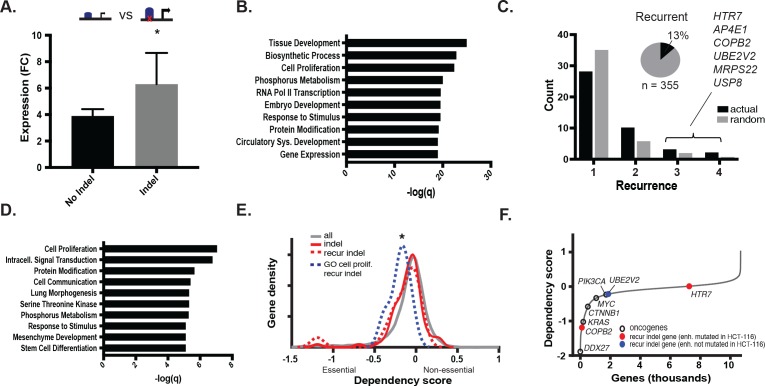
MSI enhancer indels impact target gene expression.(A) Mean fold-change of expression (CRC/crypts) of genes associated with gained enhancers containing indels (grey; n = 352 sample-gene pairs) versus the same genes in cell lines with gained enhancers but lacking indels (black; n = 2384 sample-gene pairs). *p<0.01, 2-sample t-test (Figure 3—source data 1). (B) Enriched GO terms associated with enhancer indel genes. (C) (black) Distribution of number of TCGA samples with recurrent indel and (grey) average recurrence distribution from random sampling of TCGA indels (p<0.05, χ2 test). Listed genes have indels recurrent in three or more TCGA samples. Pie chart shows fraction of enhancer indels that are recurrent in at least one primary CRC tumor (Figure 3—source data 2). (D) Enriched GO terms associated with recurrent enhancer indel genes. (E). Distribution of dependency scores in HCT-116 cells for all expressed genes (grey; n = 13,584), indel genes (red; n = 100), recurrent indel genes (dotted-red; n = 17), and recurrent indel genes with ‘Cell Proliferation’ annotation (dotted-blue; n = 5). *p<0.05 for ‘Cell Proliferation’ recurrent indel gene versus all expressed genes, Wilcox ranksum test. (F) Genes ranked by dependency scores, showing select oncogenes (black circles), and recurrent indel genes with (red circles) and without (blue circles) enhancer mutation in HCT-116 cells. Data for recurrent indel genes shown in ‘C’ (USP8, AP4E1, MRPS22) were not available.10.7554/eLife.40760.011Figure 3—source data 1.Expression of predicted target genes of enhancer indels, recurrence of indels in primary tumors, and enriched GO terms.10.7554/eLife.40760.012Figure 3—source data 2.Expression of predicted target genes for all gained enhancers with an allele-biased indel, and distribution of recurrent enhancer indels in gained and shared enhancers.